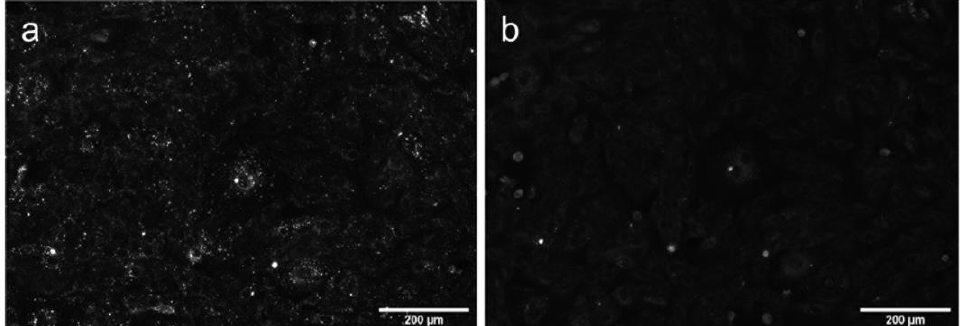
Figure 6. DAPI channel fluorescence of living A7r5 cells treated with AML and NH 4 Cl. The cells were incubated ( a ) with 300 nM AML for 15 min at 37 °C in HBSS/HEPES washed 2 times with HBSS; ( b ) the same as in ( a ), then treated with 10 mM NH 4 Cl in HBSS/HEPES, immediate reading. The images were acquired on wide-field Lionheart FX automated microscope using settings as described in the Materials and Methods section.